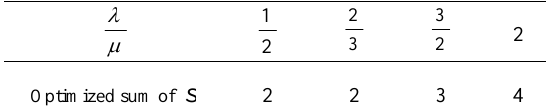
Table 1. Optimized sum of serving agents in different conditions.